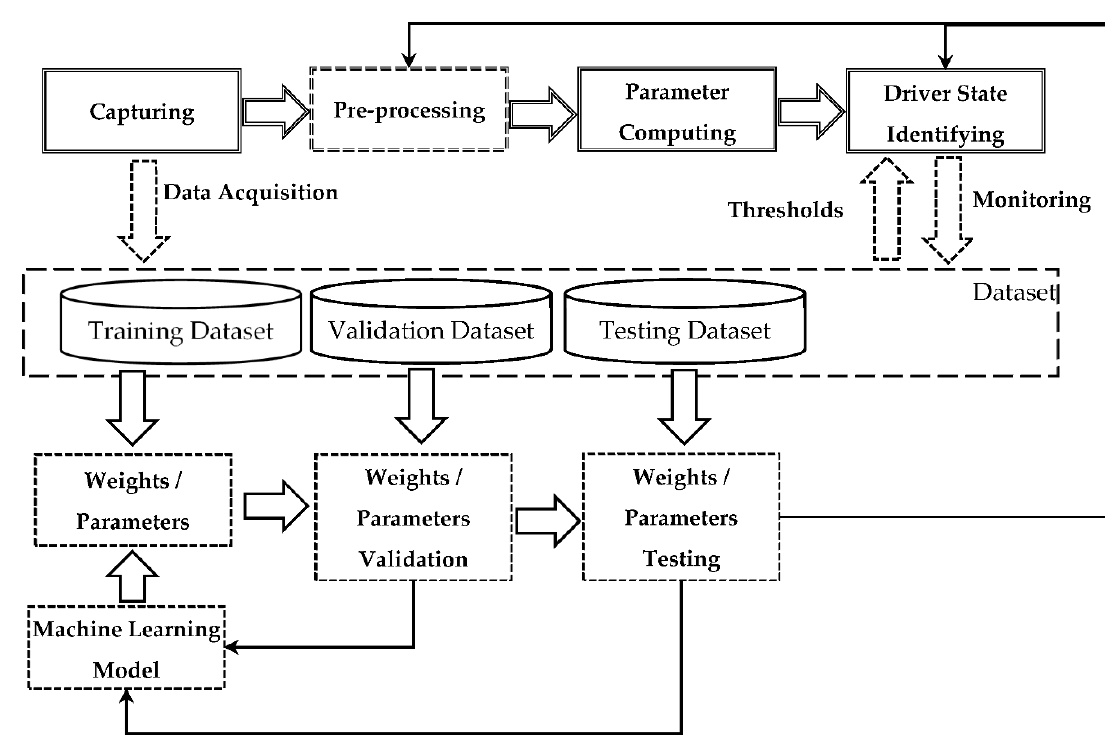
Figure 2. Proposed threat detection method.